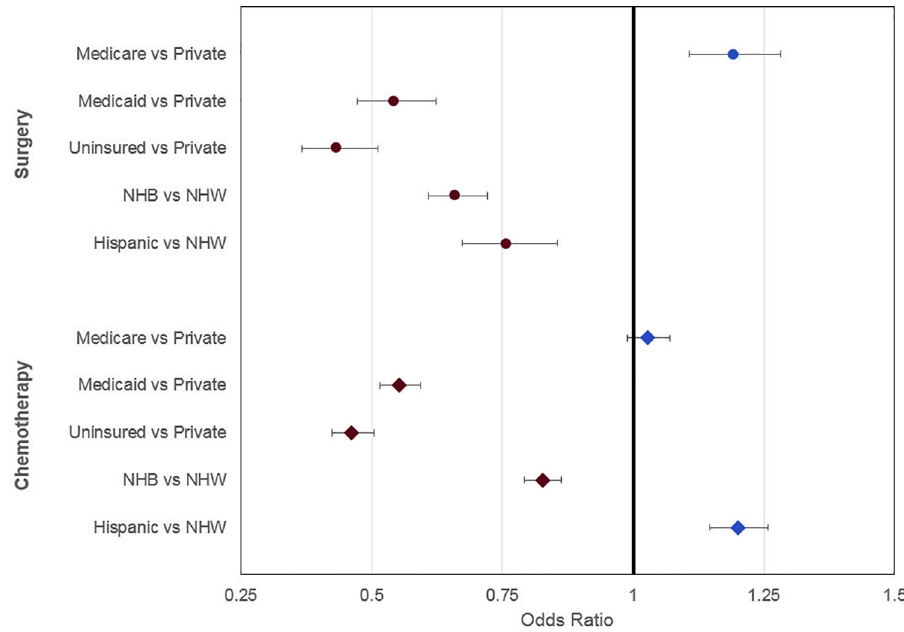
Fig 2. Adjusted odds of receiving surgery or chemotherapy by insurance and race/ethnicity. Data points represent OR, and bars represent 95% CI. Regression model also included the following covariates: age, sex, income, Charlson/ Deyo comorbidity index, stage, grade, and rurality. For the chemotherapy group, margin status and number of nodes resected were also included. CI, confidence interval; NHB, non-Hispanic Black; NHW, non-Hispanic White; OR, odds